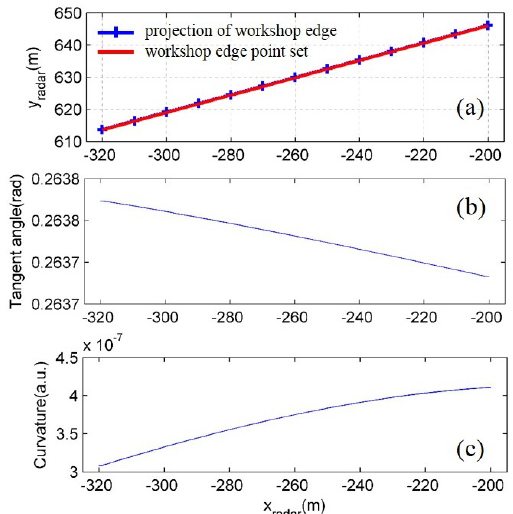
Figure 8. Projection calculation of point set on workshop roof edge into radar imaging plane: (a) workshop edge point set and projection of workshop edge; (b) angle change caused by curvature change after linear structure projection; (c) curvature change after projection calculation.